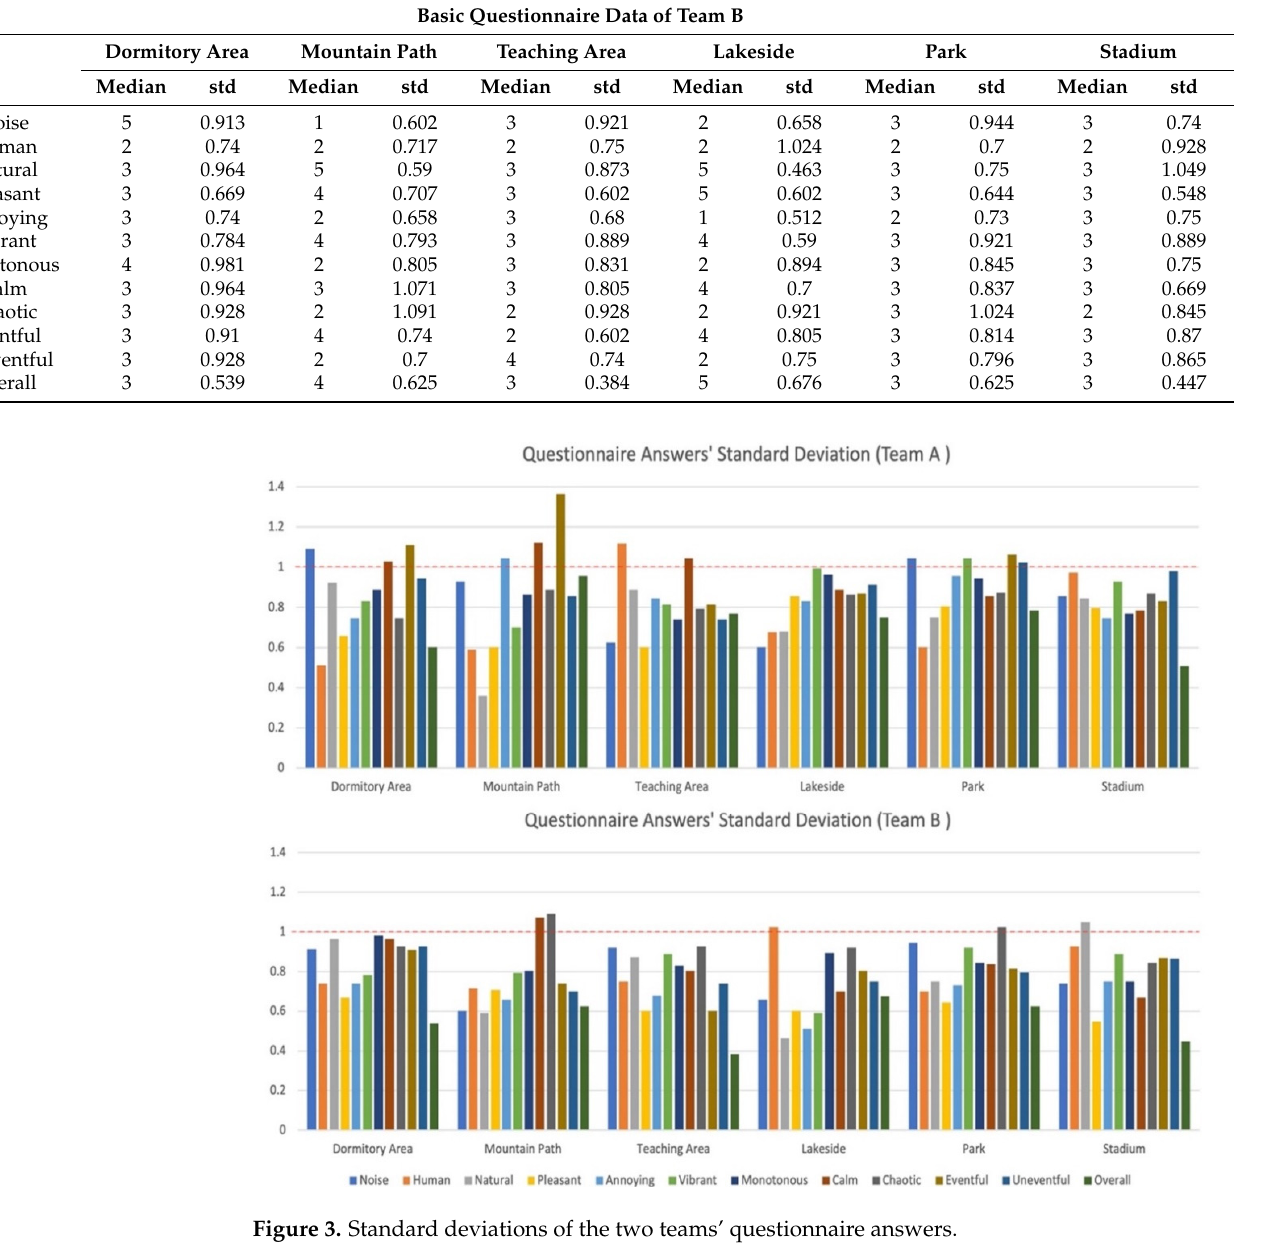
Table 3. Mann–Whitney U test p -value results of the two teams.